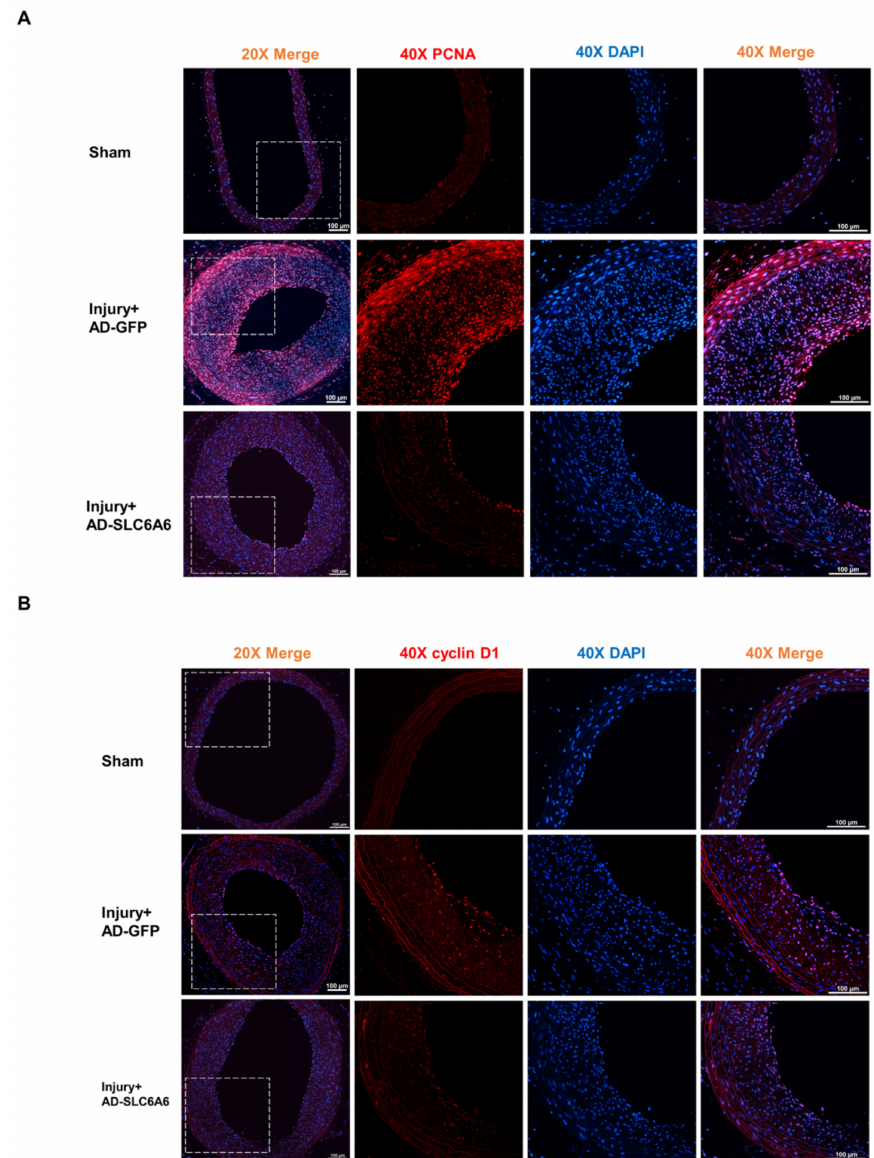
Figure 8. SLC6A6 overexpression reduced VSMC proliferation in vivo. ( A ) Immunofluorescence stain‑ ing shows PCNA (red) and DAPI (blue) expression and localization in sham group and injured carotid arteries treated with AD‑GFP or AD‑SLC6A6 for 14 days post injury. Scale bar: 100 µ m (200 × left); scale bar: 100 µ m (400 × right). ( B ) Immunofluorescence staining showing cyclin D1 (red) and DAPI (blue) expression and localization in sham group and injured carotid arteries treated with AD‑GFP or AD‑SLC6A6 for 14 days post injury. Scale bar: 100 µ m (200 × left); scale bar: 100 µ m (400 ×